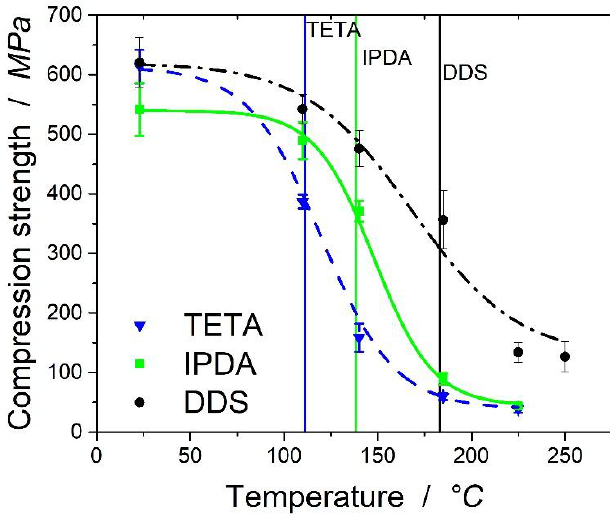
Figure 6. Compressive strength of the biaxial carbon fiber epoxy laminates with TETA, DDS, and IPDA hardeners. Fitting was performed with the formula suggested by Feih.